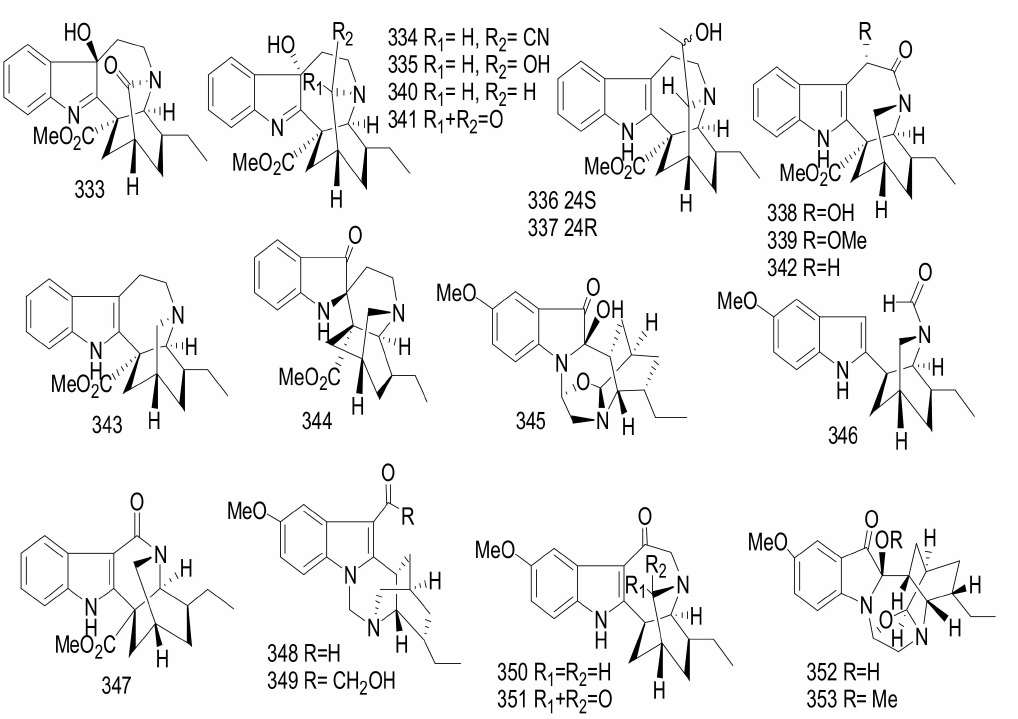
Figure 27. Compounds 333–353